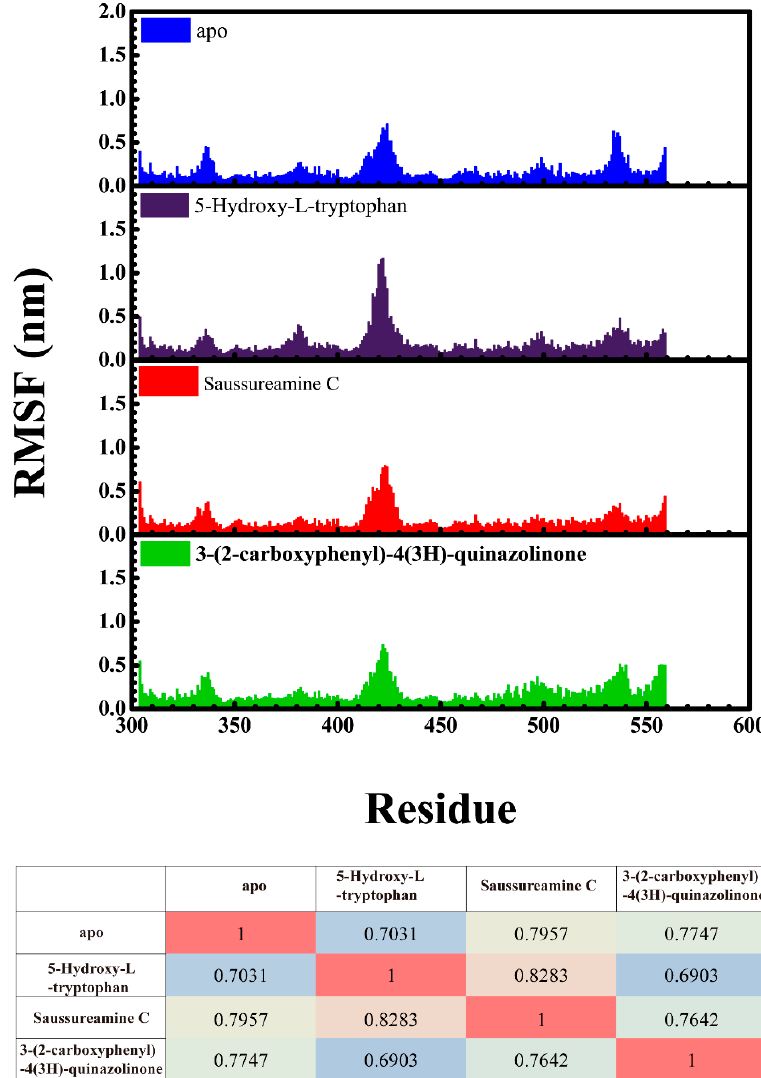
Figure 8. Root mean square fluctuation (RMSF) for residues in apo form of paraplegin protein and in paraplegin complexes with 5-hydroxy- L -tryptophan, saussureamine C, and 3-(2-carboxyphenyl)- 4(3 H )-quinazolinone and the correlation between each complex.